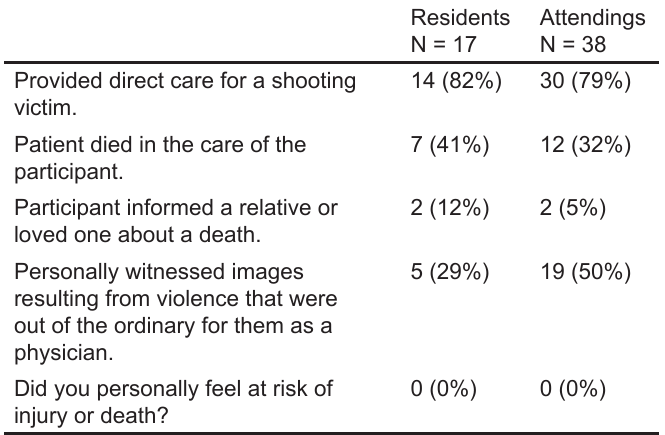
Table 2. Proportion of respondents with exposure to potentially traumatizing experiences.